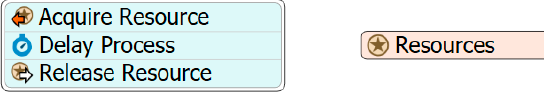
Figure 13. Resource activities in FlexSim.